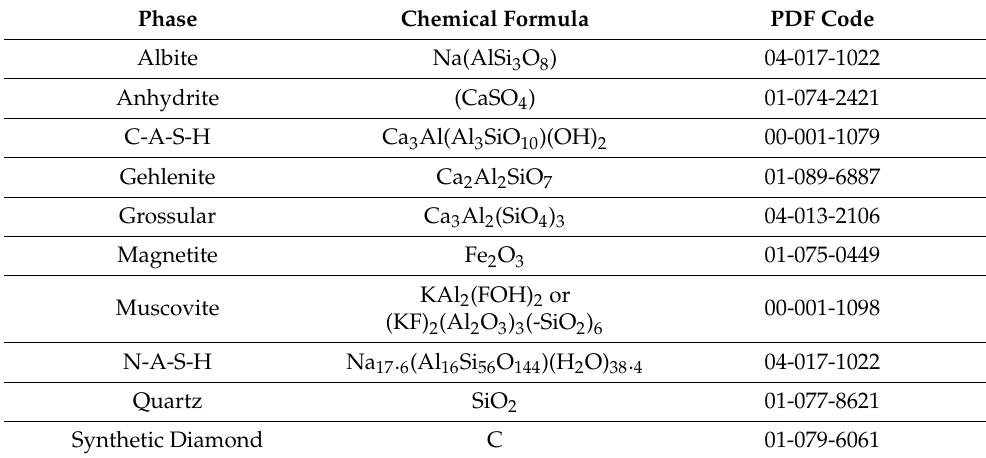
Table 1. XRD phases identified and their associated PDF